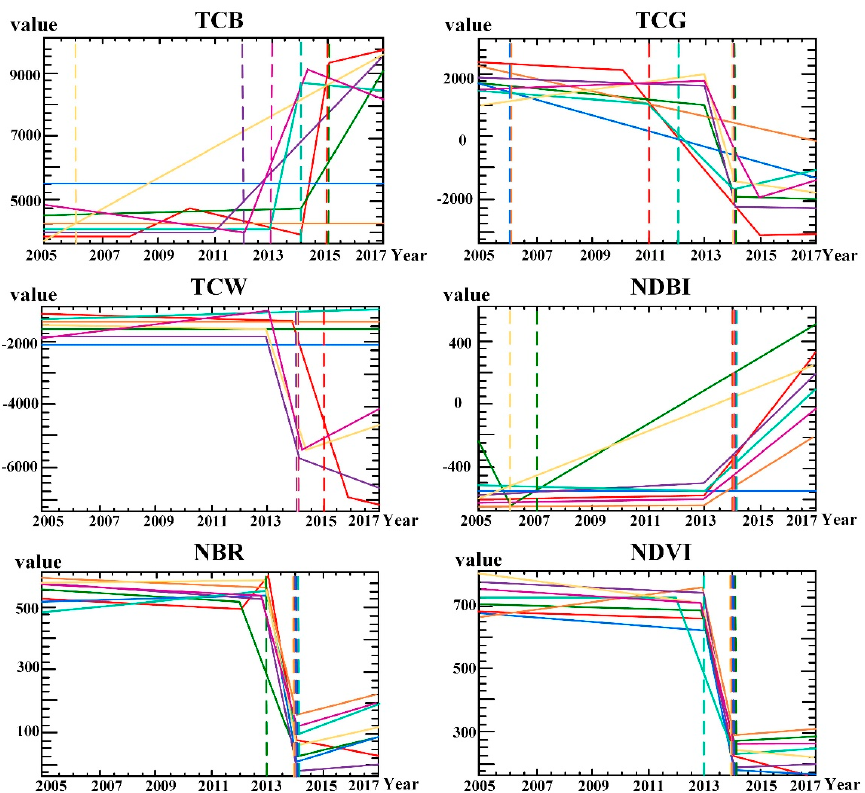
Figure 11. Comparison of time series indices. The eight colors represent the eight sample points experiencing impervious surface expansion in 2013–2014, and the dotted lines indicate the detected impervious surface expansion